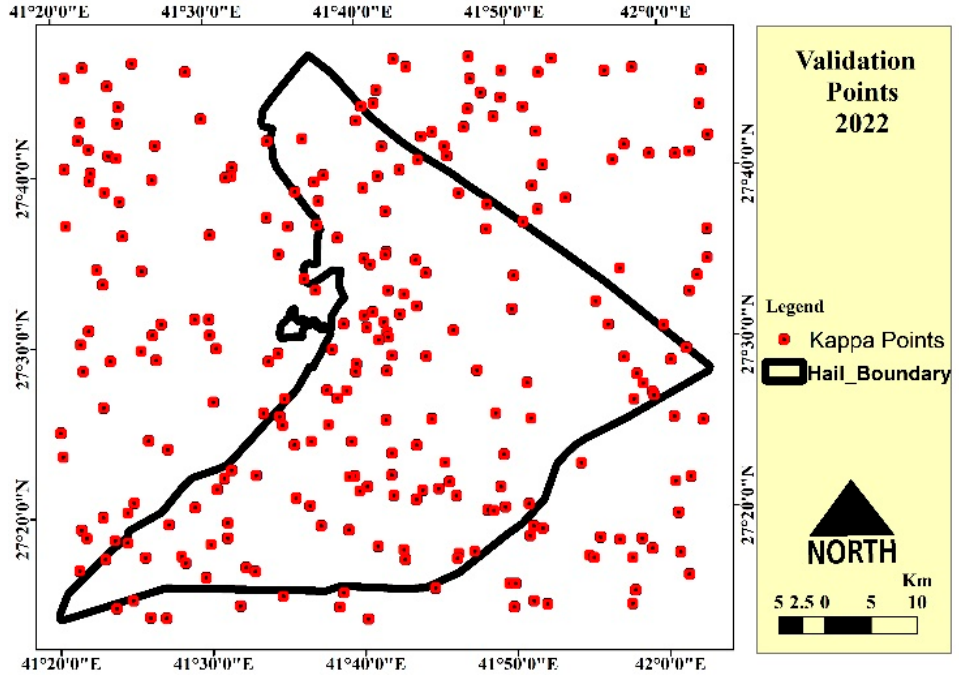
Figure 9. Distribution of Kappa validation points for 1984.